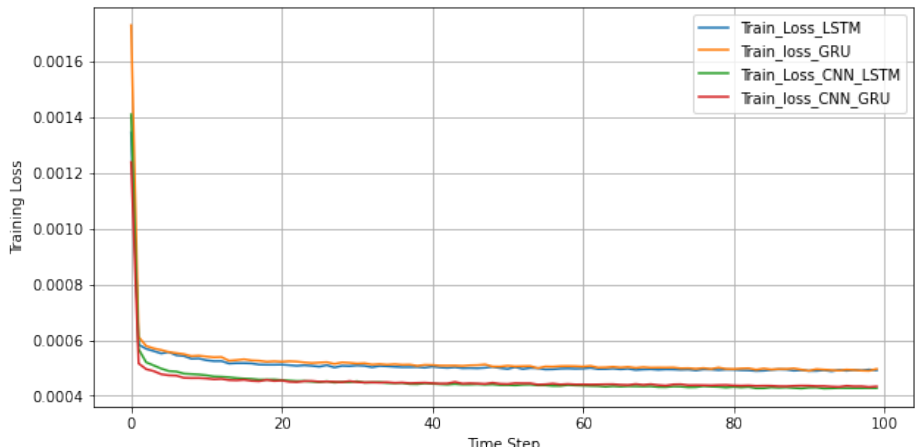
Figure 6. Training loss comparison among the different models under study.